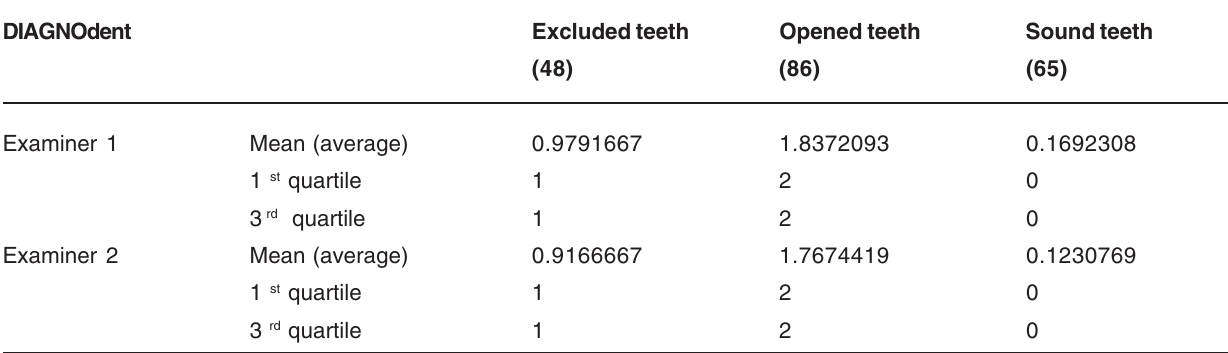
TABLE 3- Sensitivity (Se), specificity (Sp), positive (PPV), negative (NPV) predict value and likelihood ratio (LR) of the methods for detection of dentin caries Methods